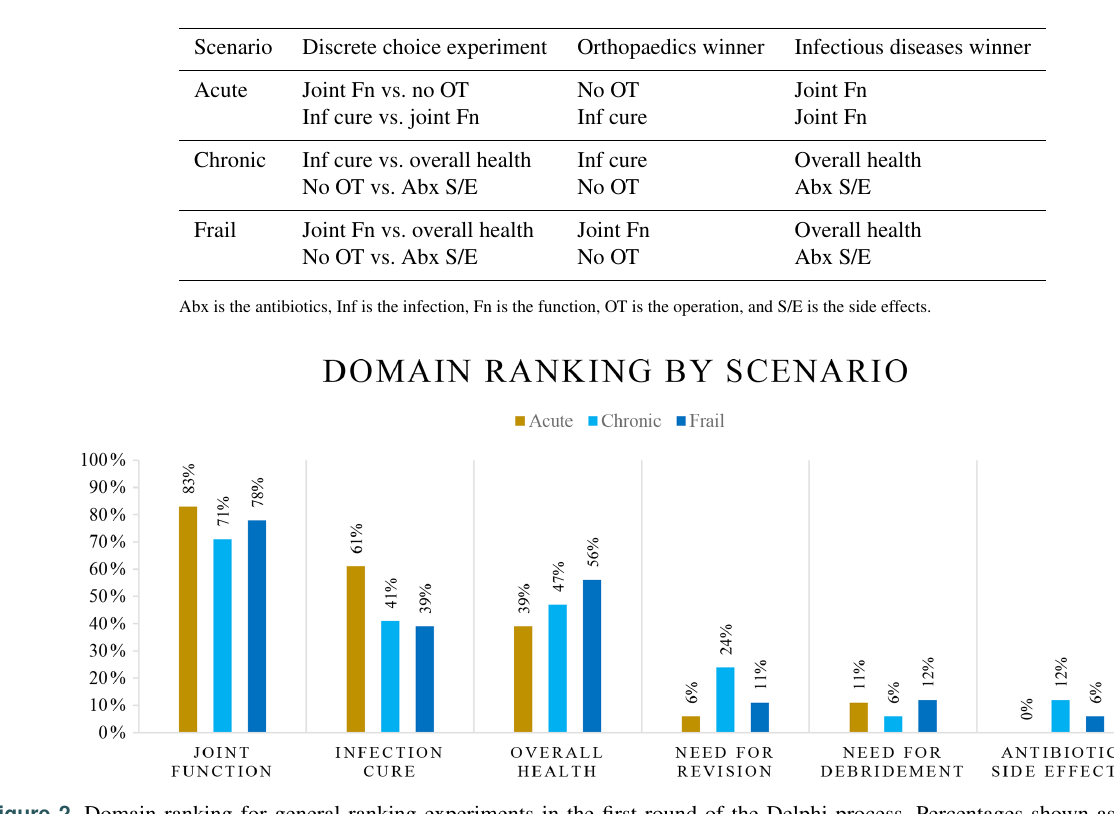
Table 3. General discrete choice experiments with speciality disagreement.